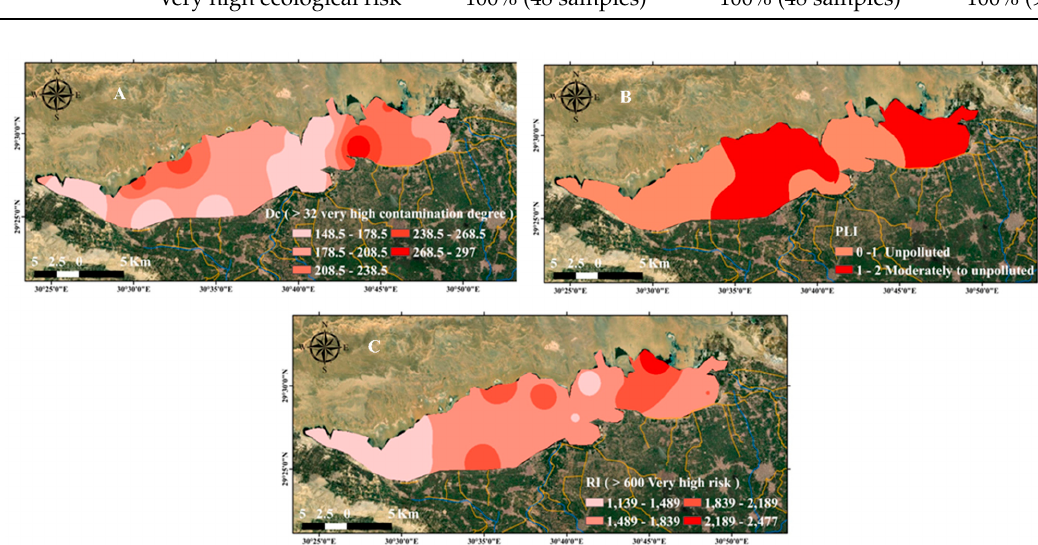
Figure 2. Spatial distribution maps of sediment quality indices: A . Degree of contamination (Dc); B . Pollution load index (PLI); and C . potential risk index (RI) in year 2018.